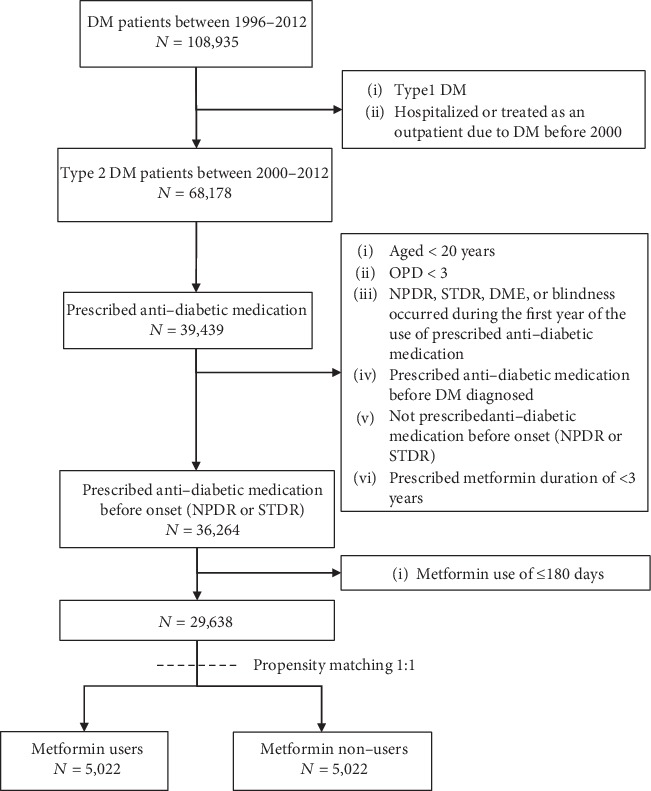
Study flow chart.